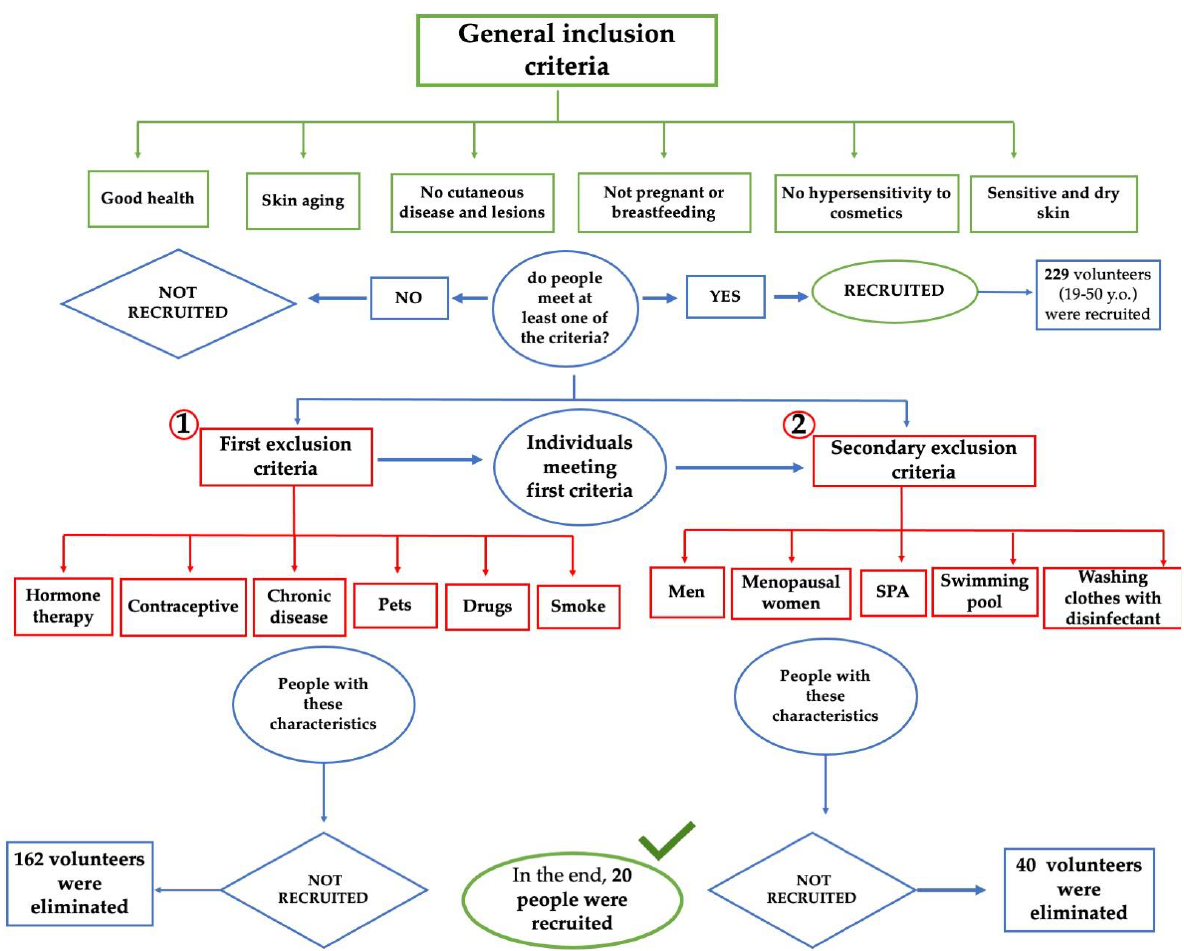
Figure 1. Flow chart of primary (1) and secondary (2) criteria used for the selection of